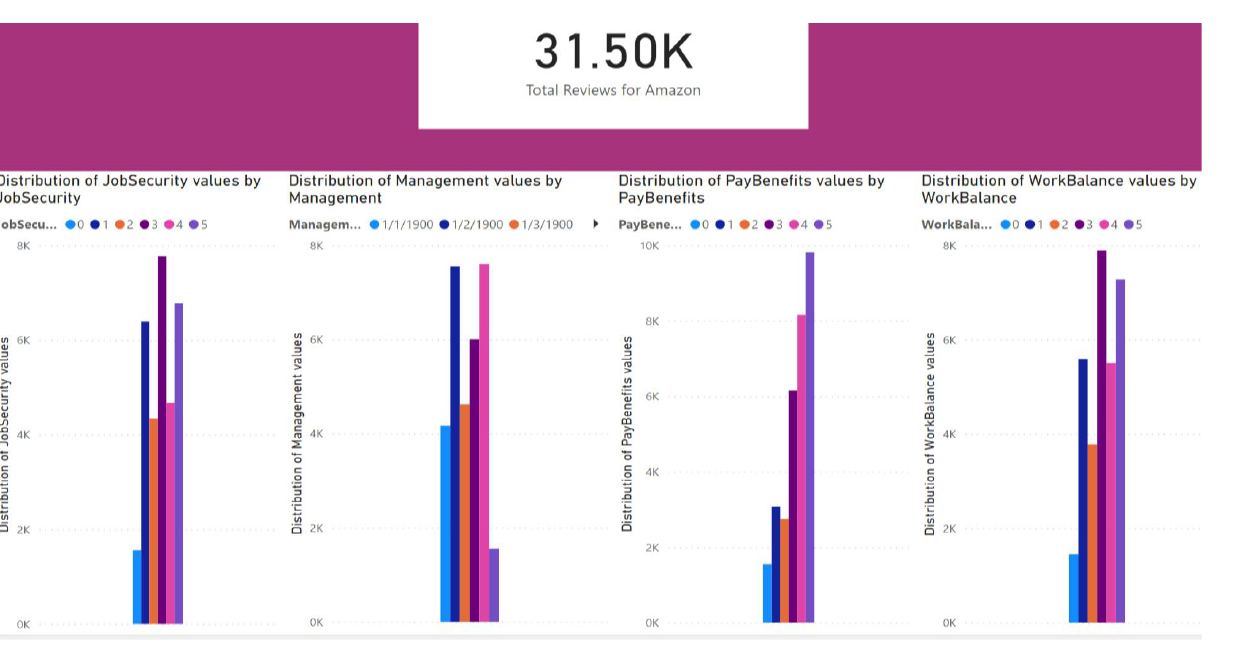
Figure 6. General distribution observed on the input data.